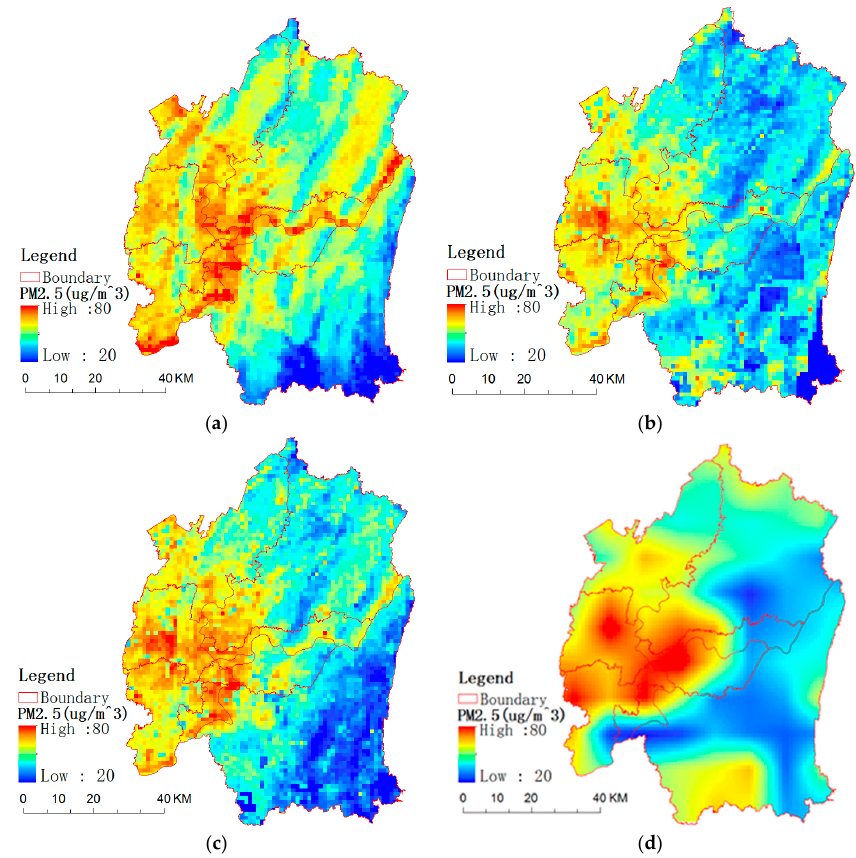
Figure 8. The spatial distribution of average PM 2.5 estimated concentration by FY-3C/MERSI in cold seasons ( a ), warm seasons ( b ), and the annual average ( c ), respectively; ( d ) represents the annual average PM 2.5 concentration by MODIS.